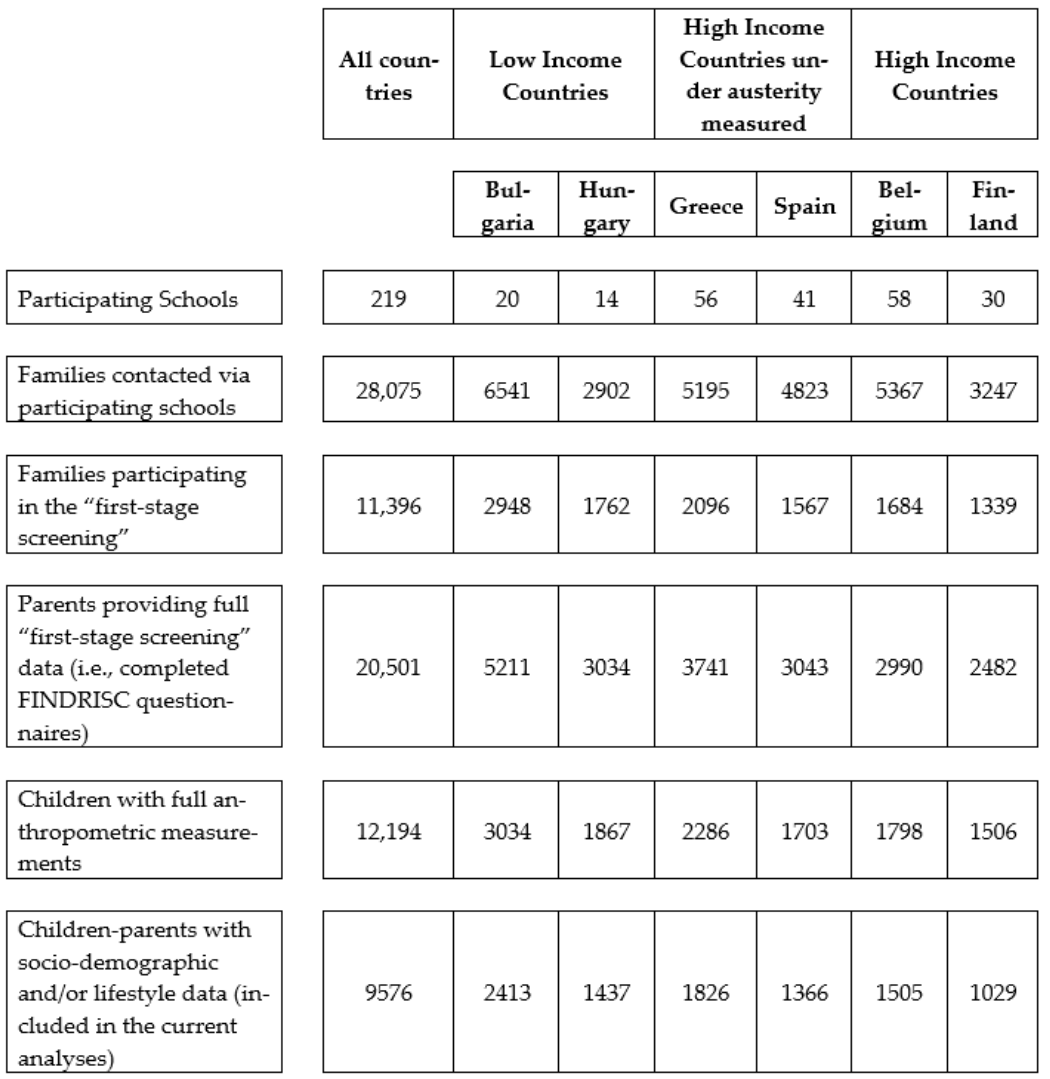
Figure 1. Flow chart of study participants in the Feel4Diabetes study.